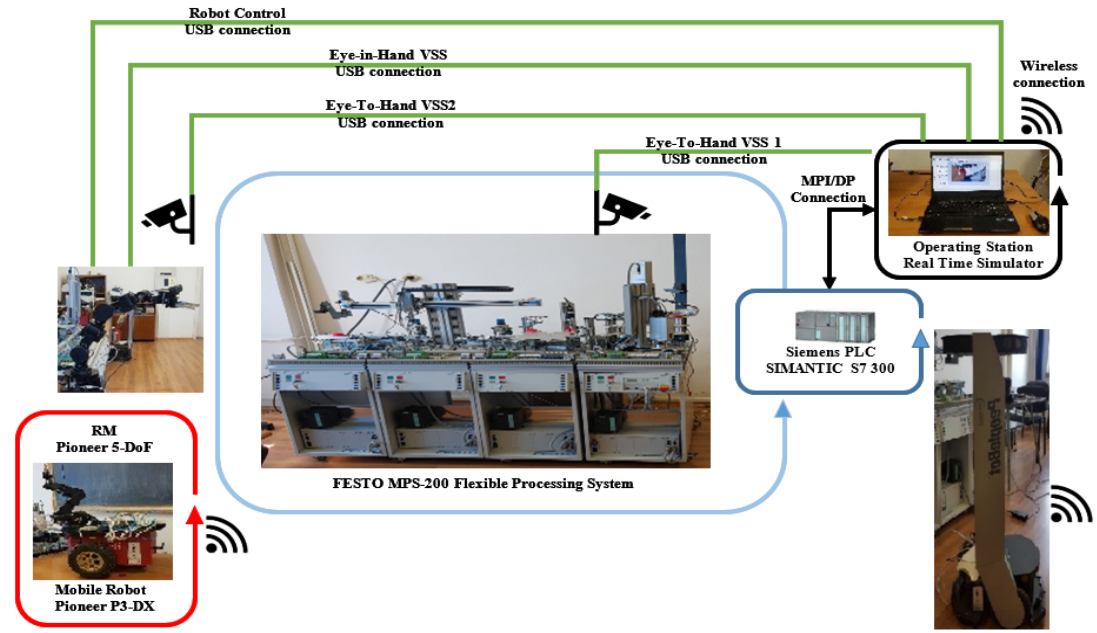
Figure 12. Communication block set of P/RML, assisted by two ARSs, two eyes to hand and one eye in hand VSSs [9]. @2019 IEEE eye in hand VSSs [9]. @2019